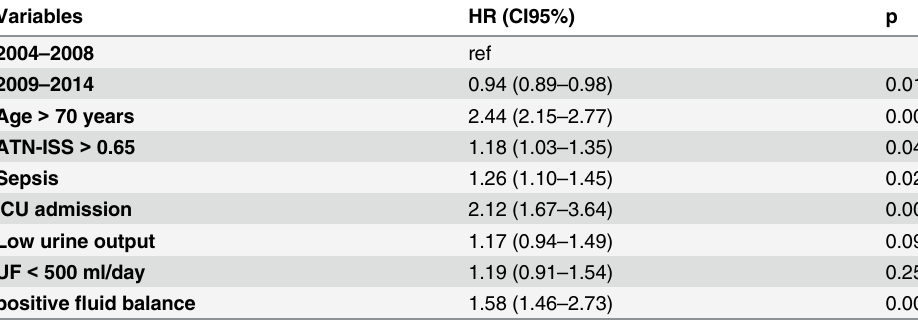
Table 6. Subdistribuition Hazard Ratio of Covariates for